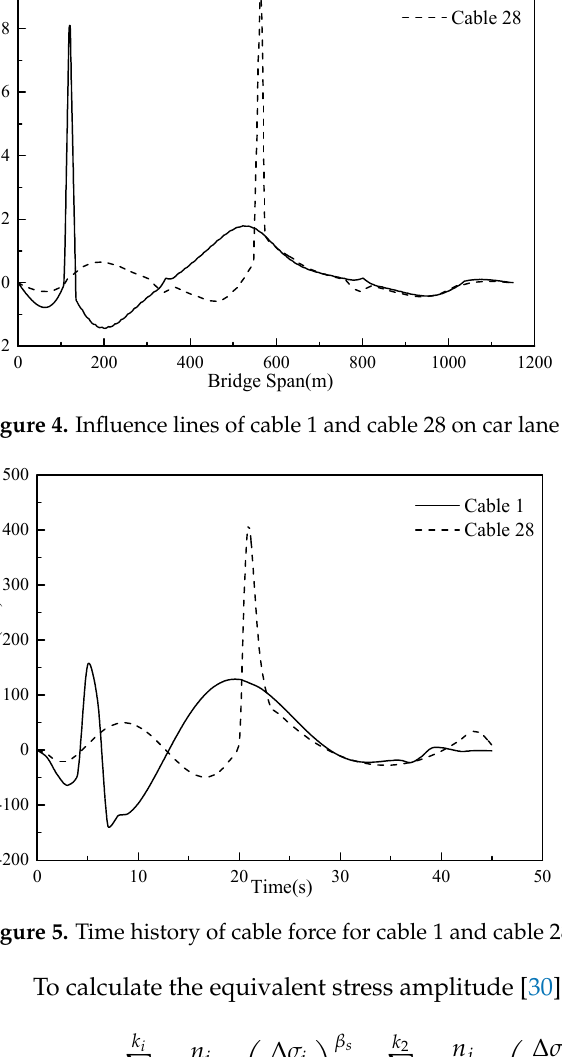
Figure 3. Influence lines of cable 1 on each traffic lane.